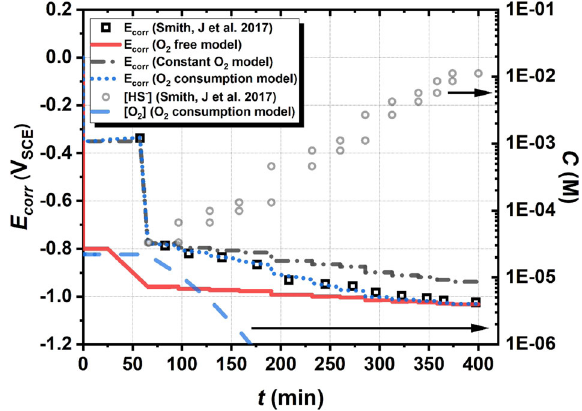
Fig. 2 Validation of simulated corrosion potential with experi- mental data. Comparison of experimentally measured by Smith et al. and numerically simulated corrosion potentials ( E corr ) of copper specimens immersed in solutions containing different HS − concen- trations, the left y -axis stands for corrosion potential (V SCE ) and right y -axis stands for O 2 and HS − concentration 32